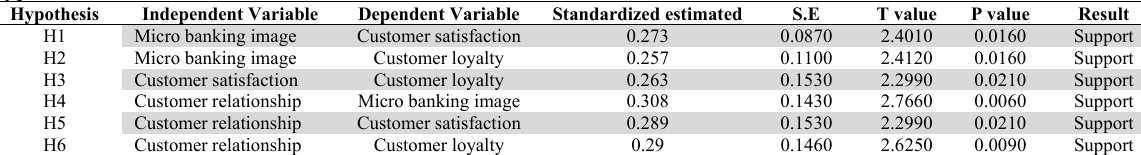
Hypotheses test